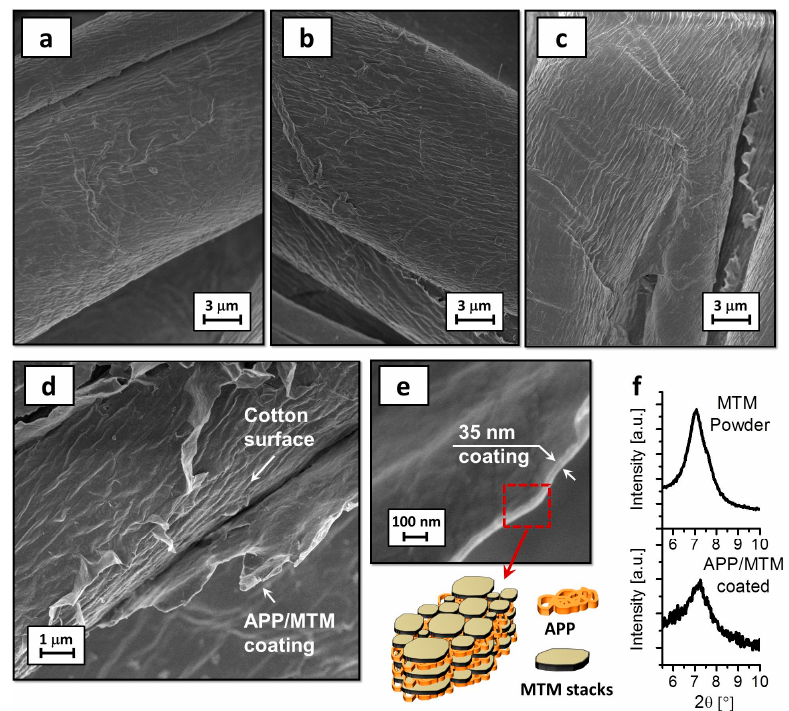
Figure 1. FE-SEM (Field-Emission Scanning Electron Microscopy) micrographs of: neat cotton ( a ); 2.5% APP/MTM sample ( b ); 5% APP/MTM sample ( c ); details of 5% APP/MTM ( d , e ); and XRD spectra of neat MTM and 5% APP/MTM fabric ( f ).